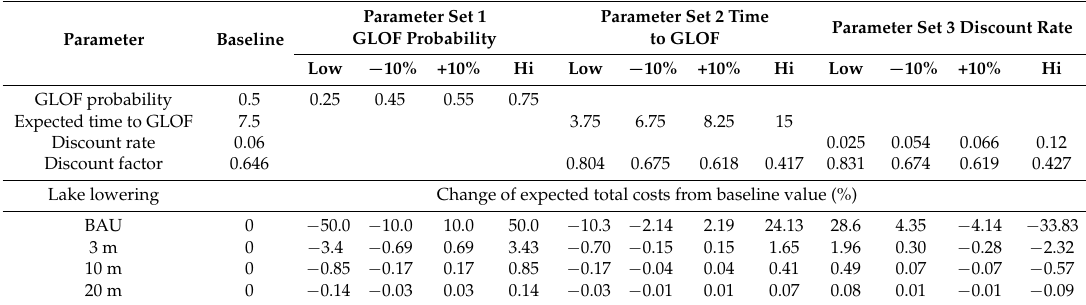
Table 7. Sensitivity analysis results showing the change in expected total costs due to changes in the parameter